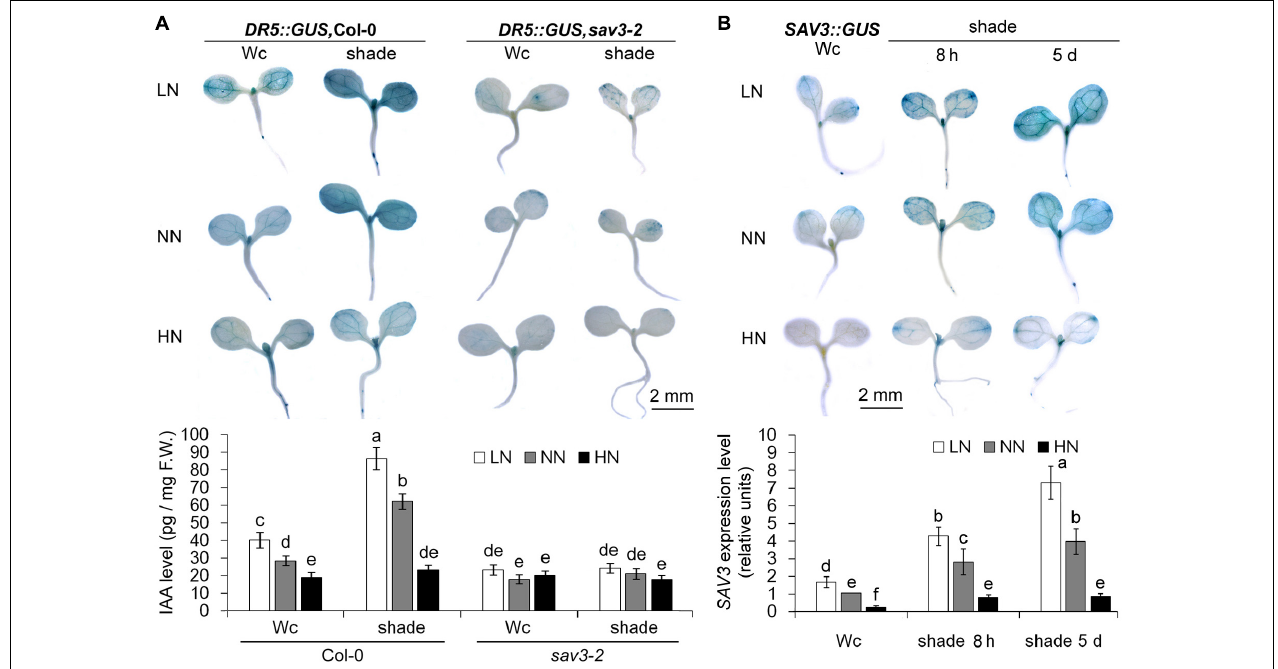
FIGURE 3 | Shade avoidance 3-mediated auxin accumulation under shade conditions was reduced by high-N treatment. (A) Auxin accumulation pattern in 5-day-old wild-type (Col-0) and sav3-2 mutant seedlings under different N levels with or without shade treatment. The levels of auxin were reflected by DR5::GUS expression. Quantitative data of free IAA are shown in the lower panel. F.W., fresh weight; Wc, continuous white light; LN, low N condition; NN, normal N condition; HN, high N condition. (B) SAV3 expression pattern in 5-day-old wild-type seedlings under different N levels with or without (8-h or 5-day) shade treatment. The levels of SAV3 gene expression were reflected by SAV3::GUS expression. Quantitative real-time PCR data of SAV3 transcript are shown in the lower panel. The individual gene expression levels were presented as the fold-changes relative to ACTIN7 expression levels. The expression level of the seedlings grown under continuous white light (Wc) with the normal N level (NN) was normalized into “1.0.” Bars represent standard deviations of three independent replicates. Values followed by different letters are significantly different at P < 0.05 according to Duncan’s multiple range test.